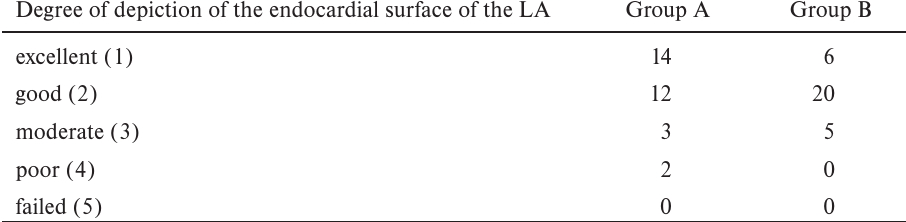
Table 3. Number of subject according to visual image